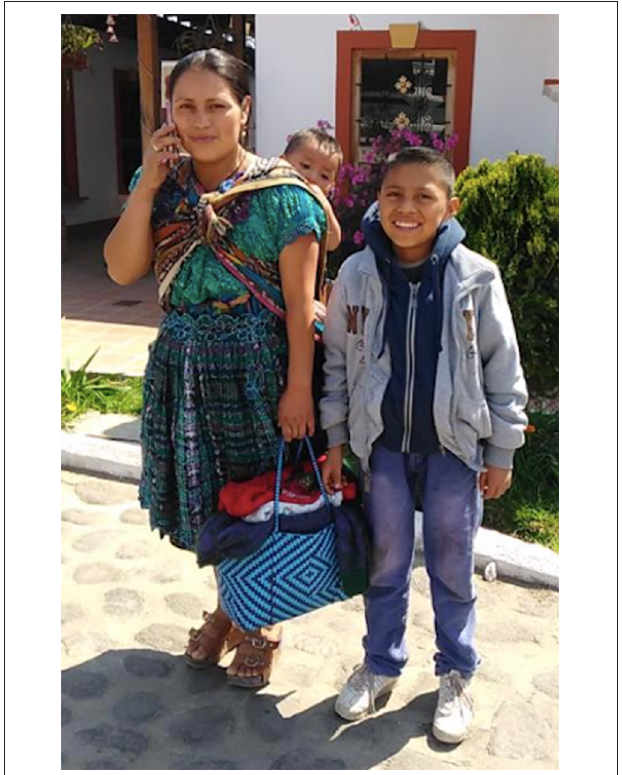
FIGURE 5 | Valenzuela Cos Matul on her cellphone, her children in tow, representing the new generation of comadronas, teaching best practices of maternal child health, the rights of women, and the impacts of gender-based violence. Photo by Betty-Anne Daviss in Totonicapán, 2017. Used with permission.